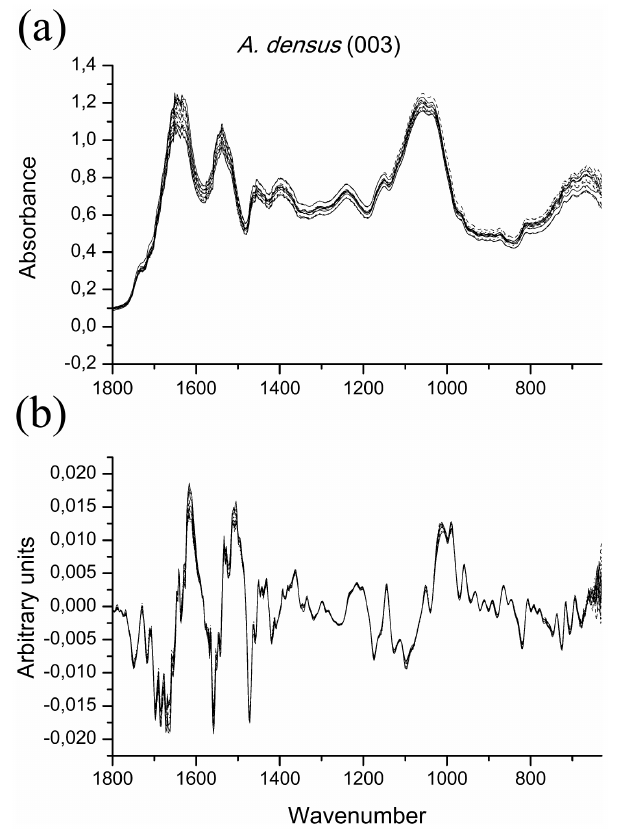
Fig. 2. Comparison of (a) raw spectra and (b) their 9-point first derivative treatment, for Ankistrodesmus densus (003). Region shown is 1800–630 cm 2 1 , representing the results for all other strains but C. clorastera (009), D. communis (030) and C. cf. sphaericum